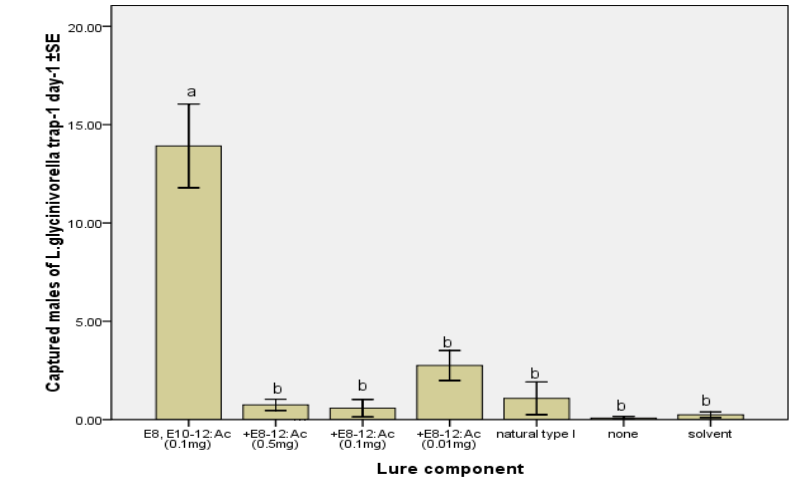
Figure 1. Mean (±SE) numbers of L. glycinivorella males captured per trap per day in traps baited with the binary blend of EE- 8,10-12:Ac and E- 8-12:Ac in different doses compared with control groups and natural type I [mixture of EE- 8,10-12:Ac (30 ng) and E 8-12:Ac (34 ng)] [8] in rubber septa. The field test was conducted in a soybean field in Harbin, China from 7 August to 17 August 2011. Bars with different letters are significantly different (ANOVA and Tukey’s HSD, p <